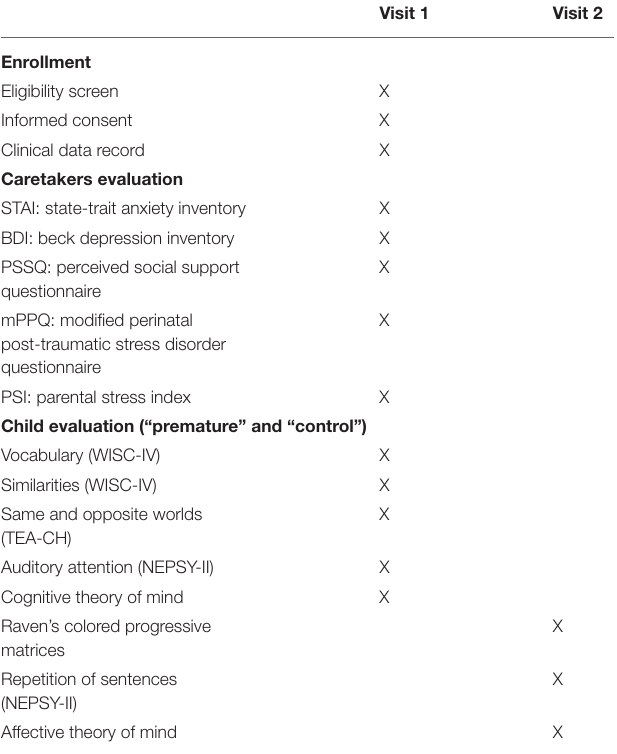
TABLE 1 | Protocol